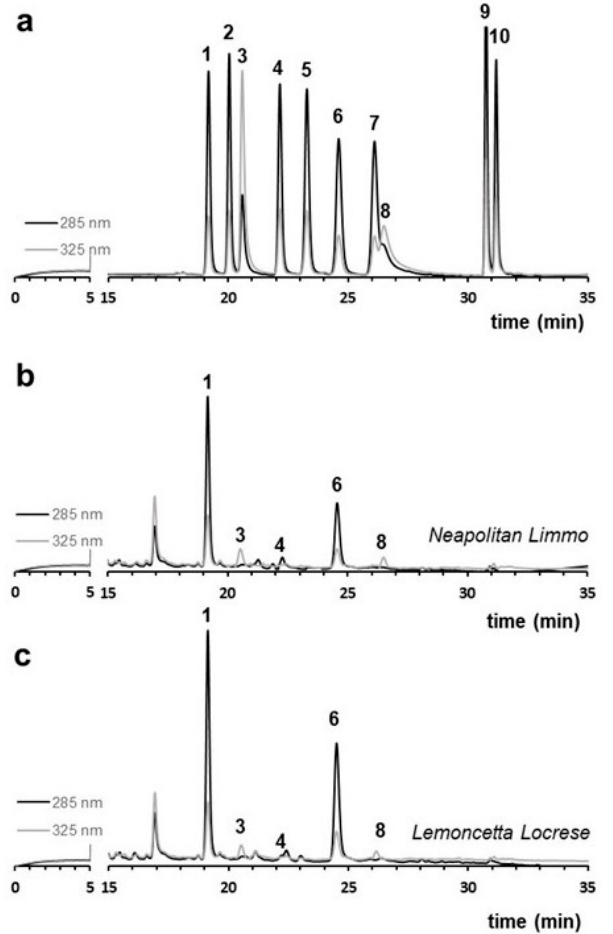
Figure 2. Liquid chromatography (LC) flavonoid profile of Neapolitan limmo and lemoncetta locrese. ( a ) Standard containing a mixture (50 mg/L) of eriocitrin (1), neo-eriocitrin (2), rutin (3), narirutin (4), naringin (5), hesperidin (6), neohesperidin (7), diosmin (8), poncirin (9), didymin (10). ( b ) LC chromatograms of Neapolitan limmo ( c ) LC chromatograms of lemoncetta Locrese. Flavanones were monitored at 285 nm (black line), flavones at 325 nm (gray line).